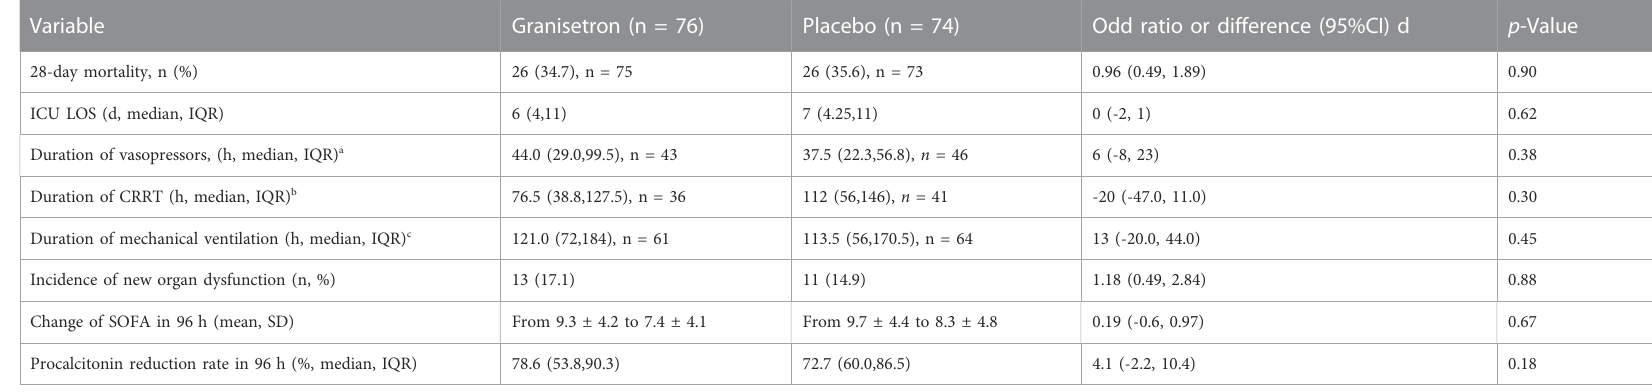
TABLE 2 Primary and secondary